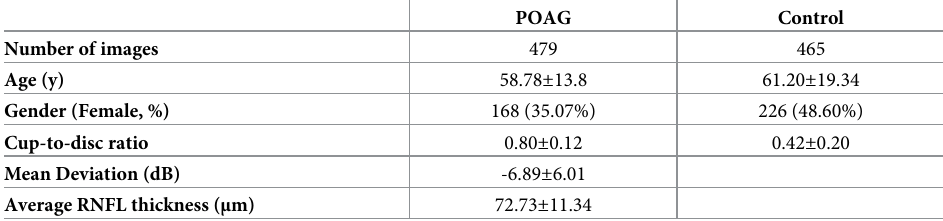
Table 1. Clinical and demographic characteristics of the image dataset from Taipei Veterans General